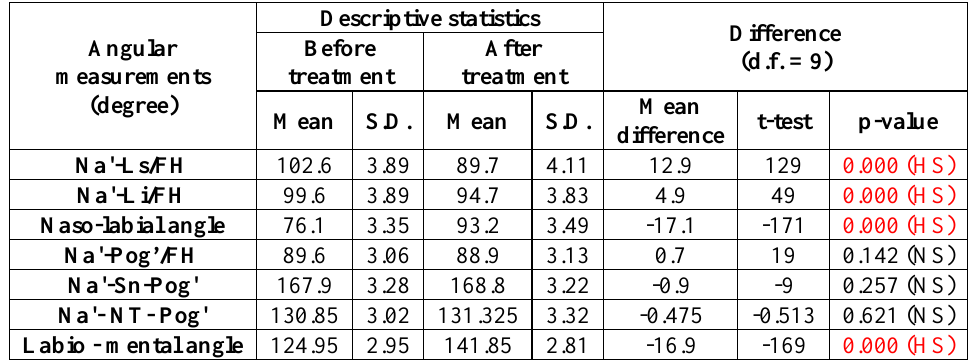
Table 1. Descriptive Statistics and Treatment Effect on the Angular Measurements.